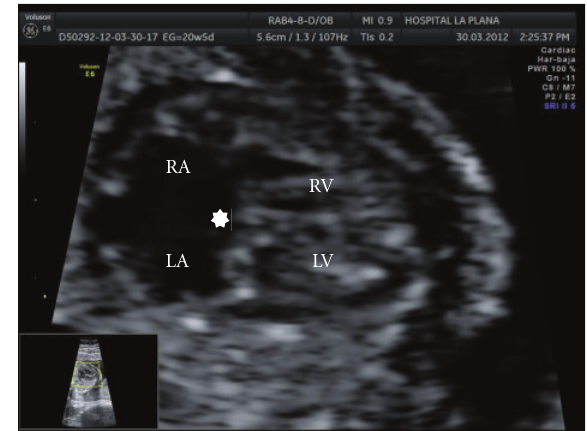
Figure 3: Atrioventricular canal. Note the absence of the crux cordis (star). RA: right atrium, LA: left atrium, RV: right ventricle, LV: left